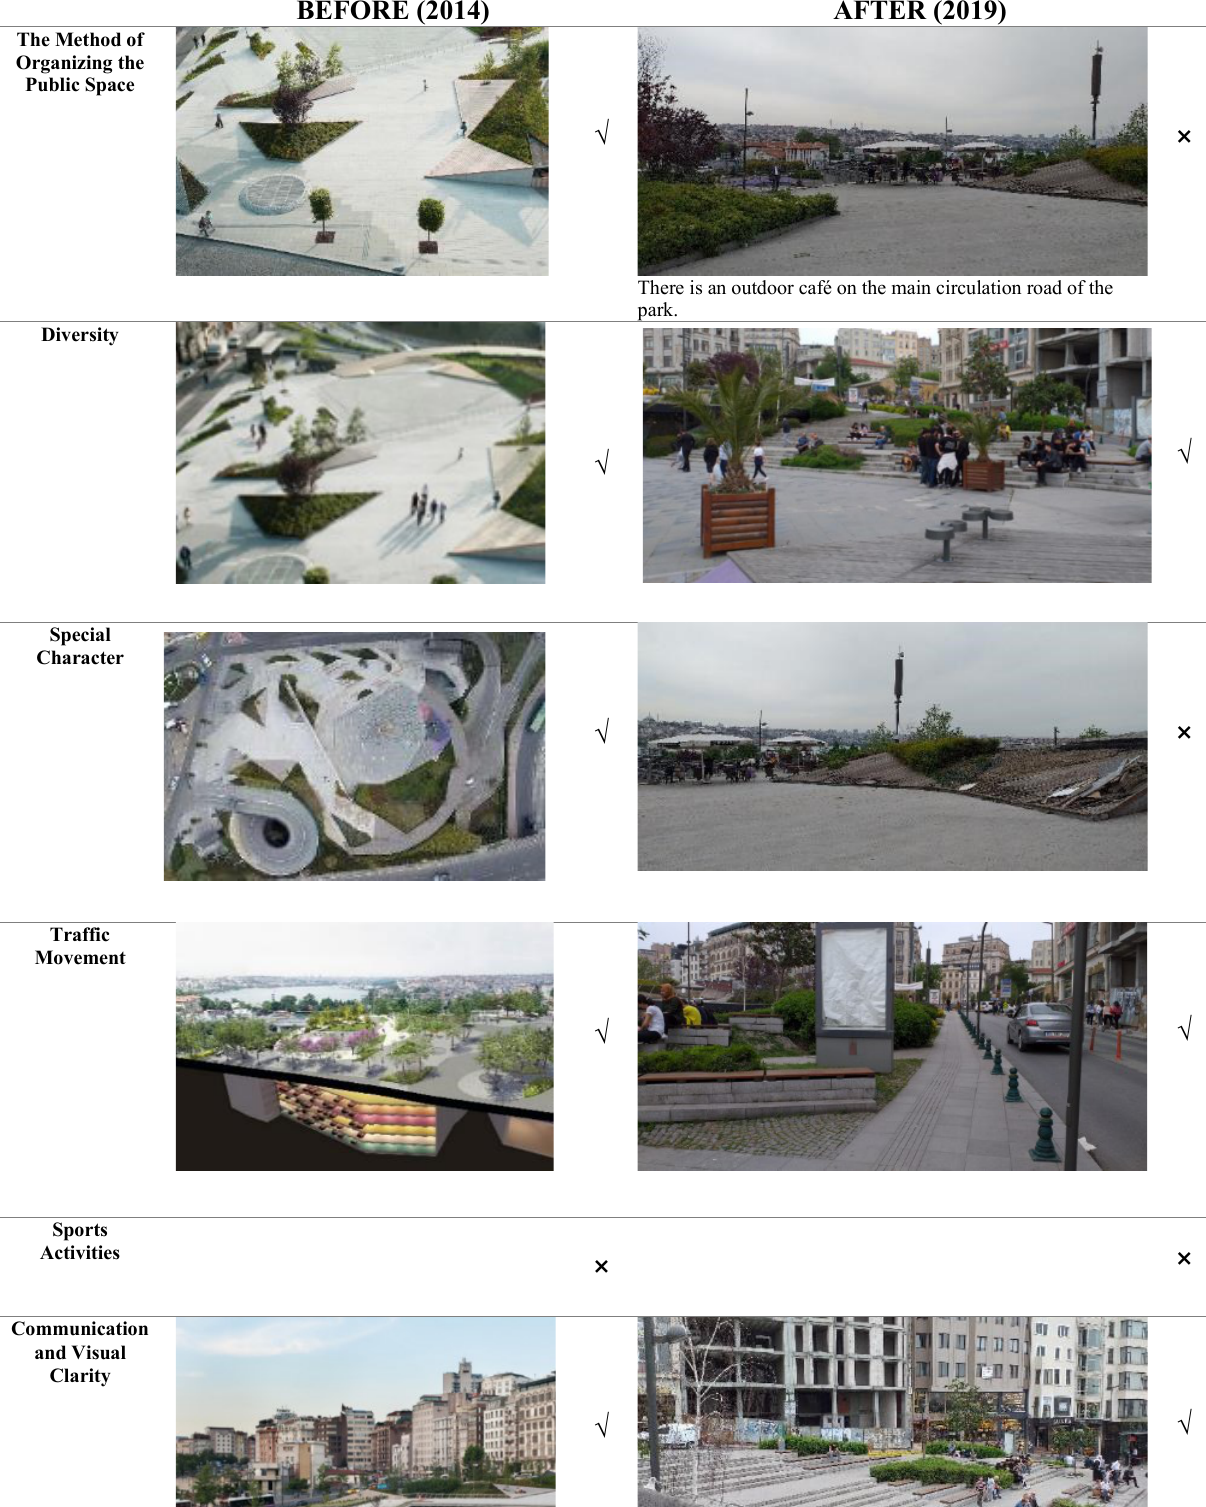
Table 7. Analysis of "Şışhane Park" according to derived functional elements; (Improved by author) (Figures source: Before - URL8, after- by